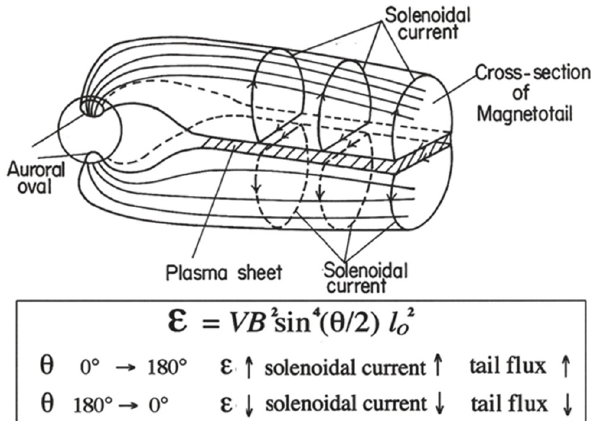
Fig. 7b. The two semicircular solenoidal currents in the magneto- tail. The flux change in the magnetotail is associated with changing power ε